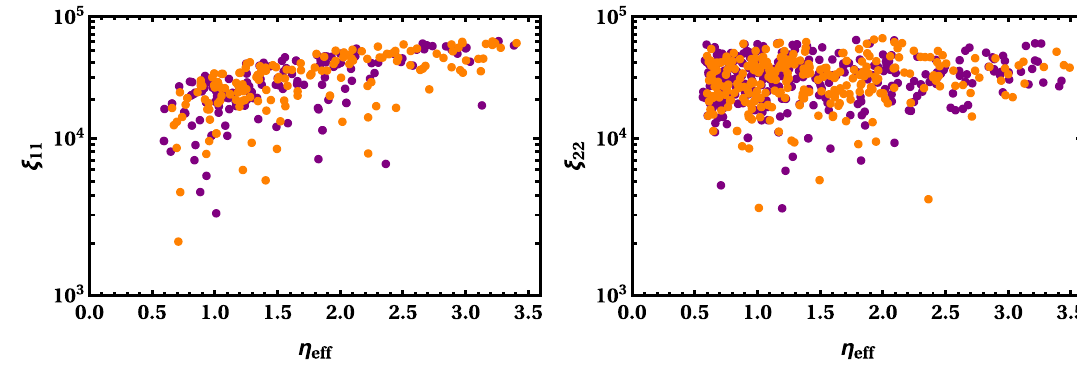
Fig. 1 The scanned points plotted for Scenario-I (Scenario-II) in η eff – ξ 11 ( η eff – ξ 22 ) plane in the left panel (right panel) respectively. The purple and orange scanned points are respectively for c χ